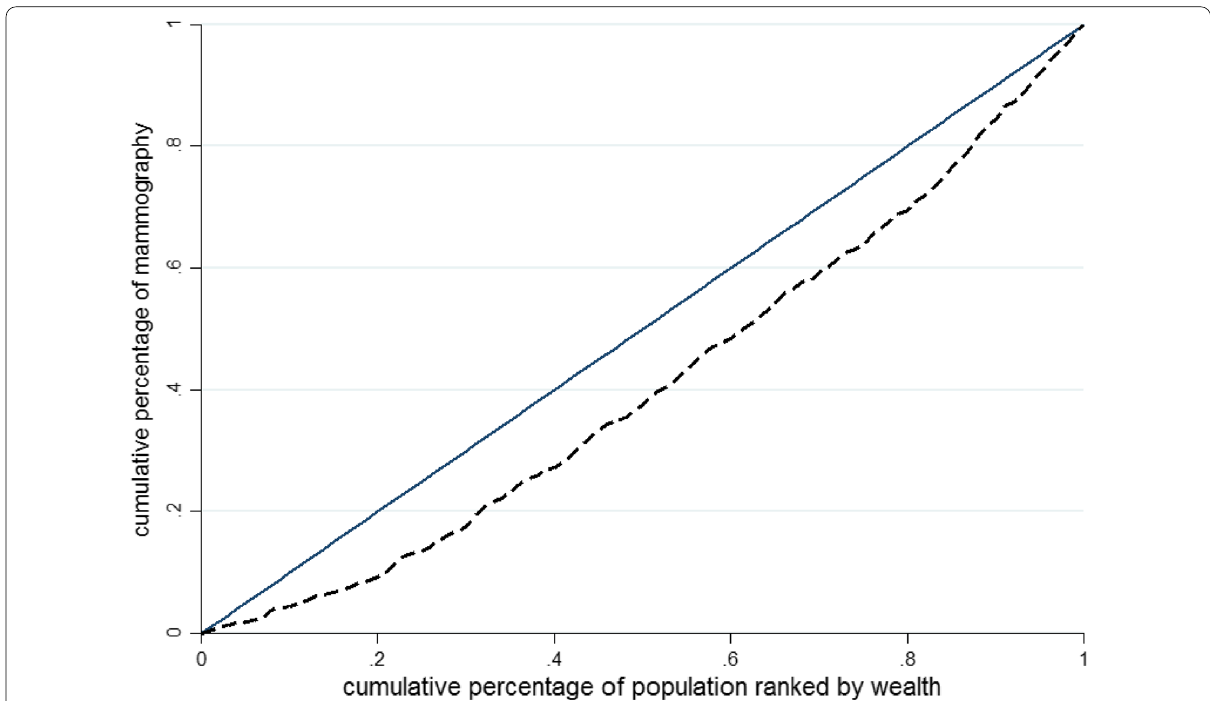
Fig. 1 The concentration curves for mammography in